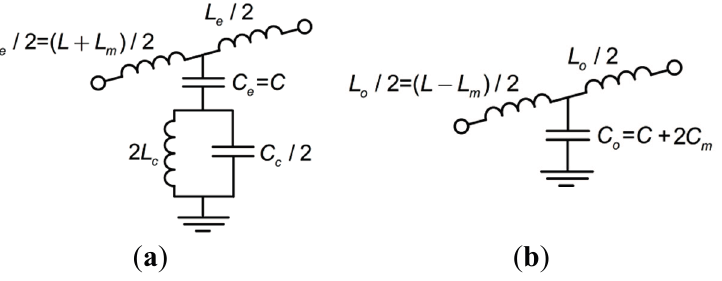
Figure 6. Circuit models for the even mode ( a ) and odd mode ( b